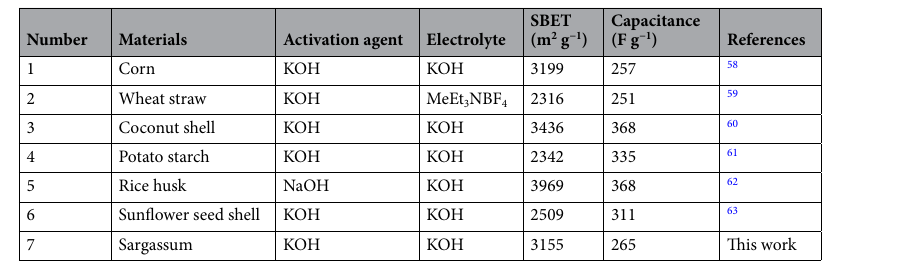
Table 11. Capacitance values at 0.1 A g − 1of biomass-based activated